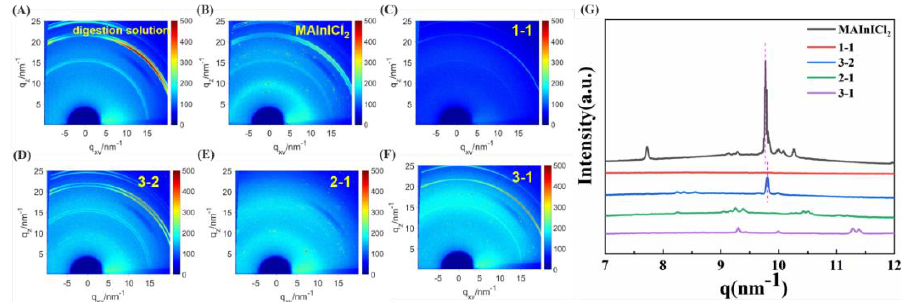
Figure 2. ( A – G ) 2D−GIWAXS images and the corresponding integrated curves of the film of the digestion solution, MAInICl 2 and mixtures in different proportions.